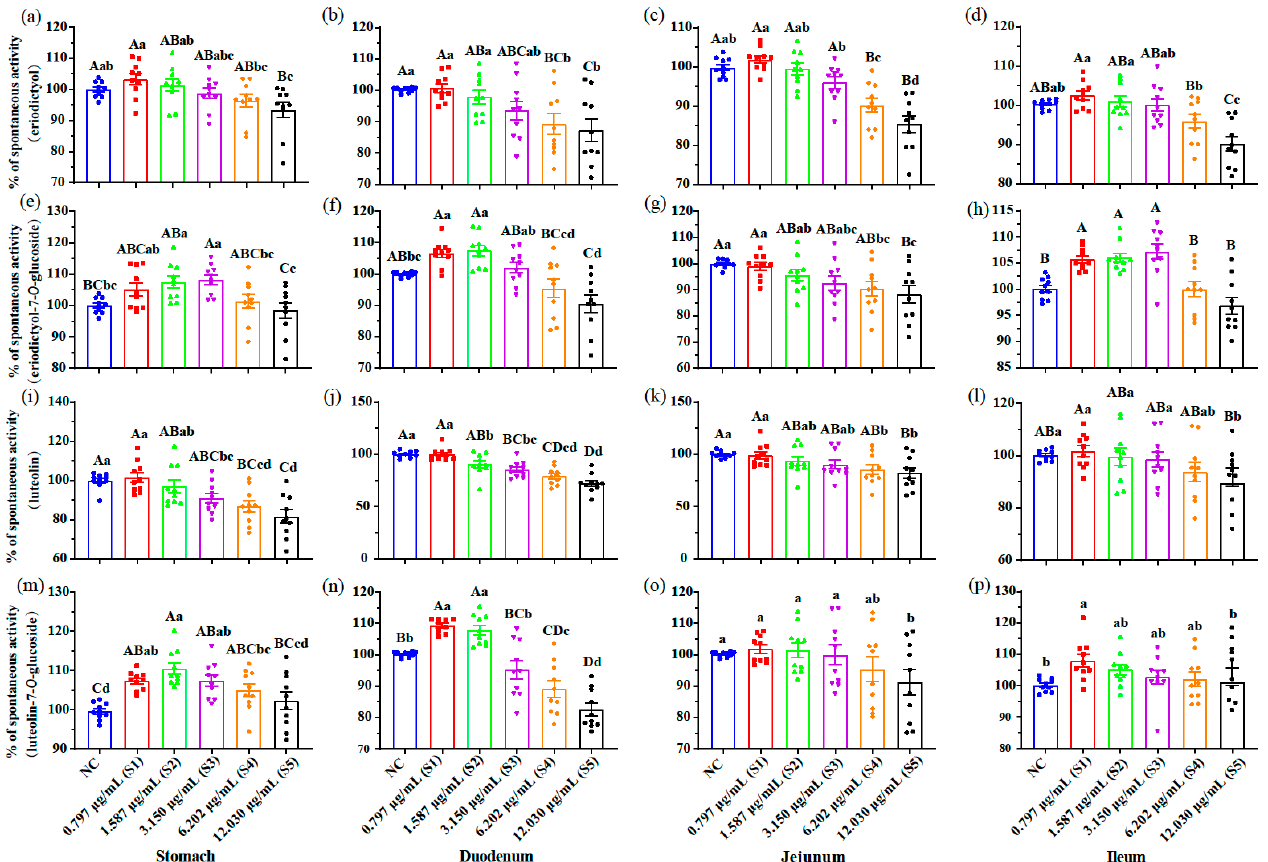
Figure 5. Effects of eriodictyol ( a – d ), eriodictyol-7- O -glucoside ( e – h ), luteolin ( i – l ) and luteolin-7- O - glucoside ( m – p ) at different concentrations on the spontaneous activity of the isolated muscle strips from four gastrointestinal tissues in vitro. The spontaneous activity of the negative control (NC) was considered as 100%. n = 10 for each group. Capital and lowercase letters above the bar indicate the difference significance at 0.01 or 0.05 level, respectively.